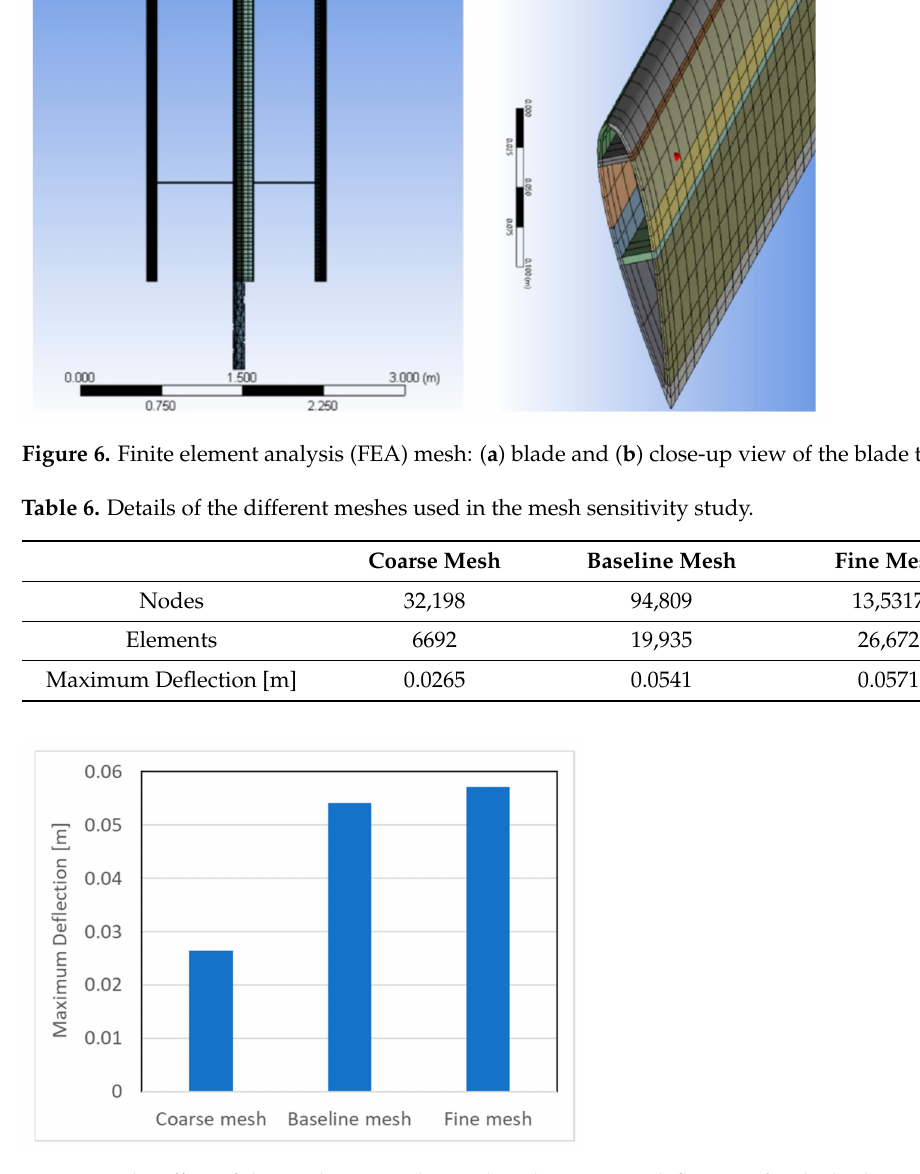
Figure 7. The effect of the mesh size on the predicted maximum deflections for the highest rotational velocity of 24.11 rad/s and using KR1